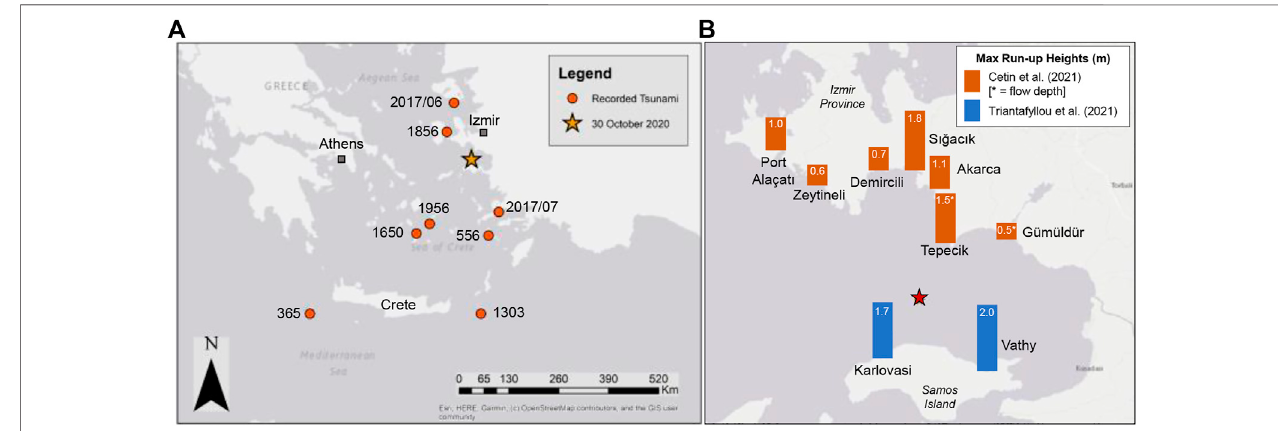
FIGURE16|(A) RecordedmajortsunamieventsintheAegeanSea (B) Measurementsofmaximumtsunamirun-upheightsinmforthemost-affectedlocationsby the tsunami along the coast of Izmir Province and Samos Island, according to Cetin et al. (2021) and Triantafyllou et al. (2021).